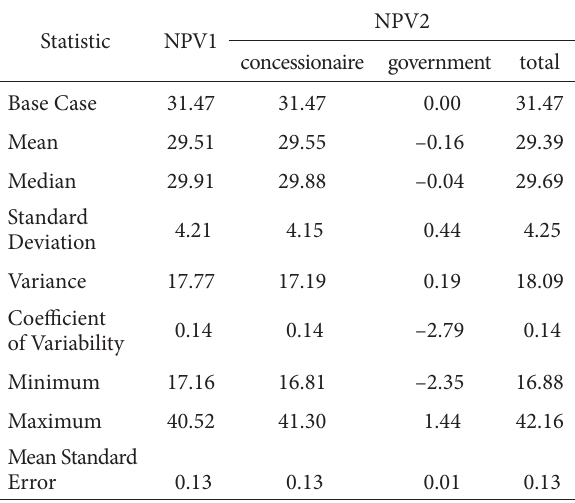
Table 2. Comparison with the optimal values of the MRG and TRC under different objectives